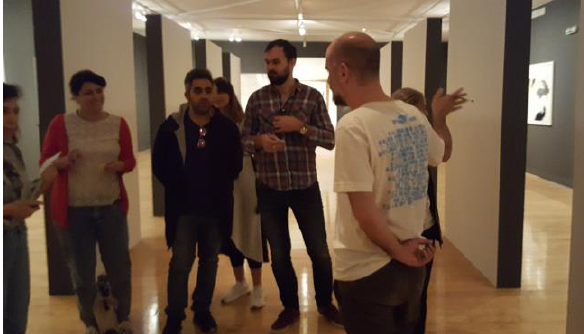
Figure 5. Snapshot from playtesting with the artist: group discussion at the centre of the